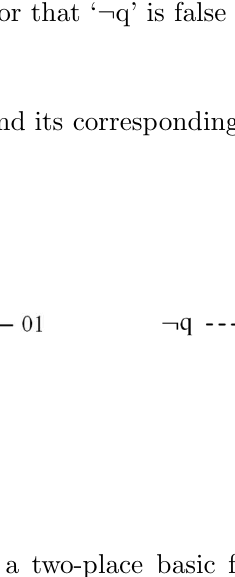
Schema 10 stands for a two-place basic formula: ⌊ p q ⌋ (pq), which means the whole expression is true iff ‘p’ is false (has value 0) and ‘q’ is true (has value 1), or both ‘p’ and ‘q’ are true. Graph 27 (also see graph 8 (a), 8(d)) stands for an assertion: ⊢ q. It means that ‘q’ is true whether ‘p’ is true or not, or that ‘ ¬ q’ is false whether ‘q’ is true or not.